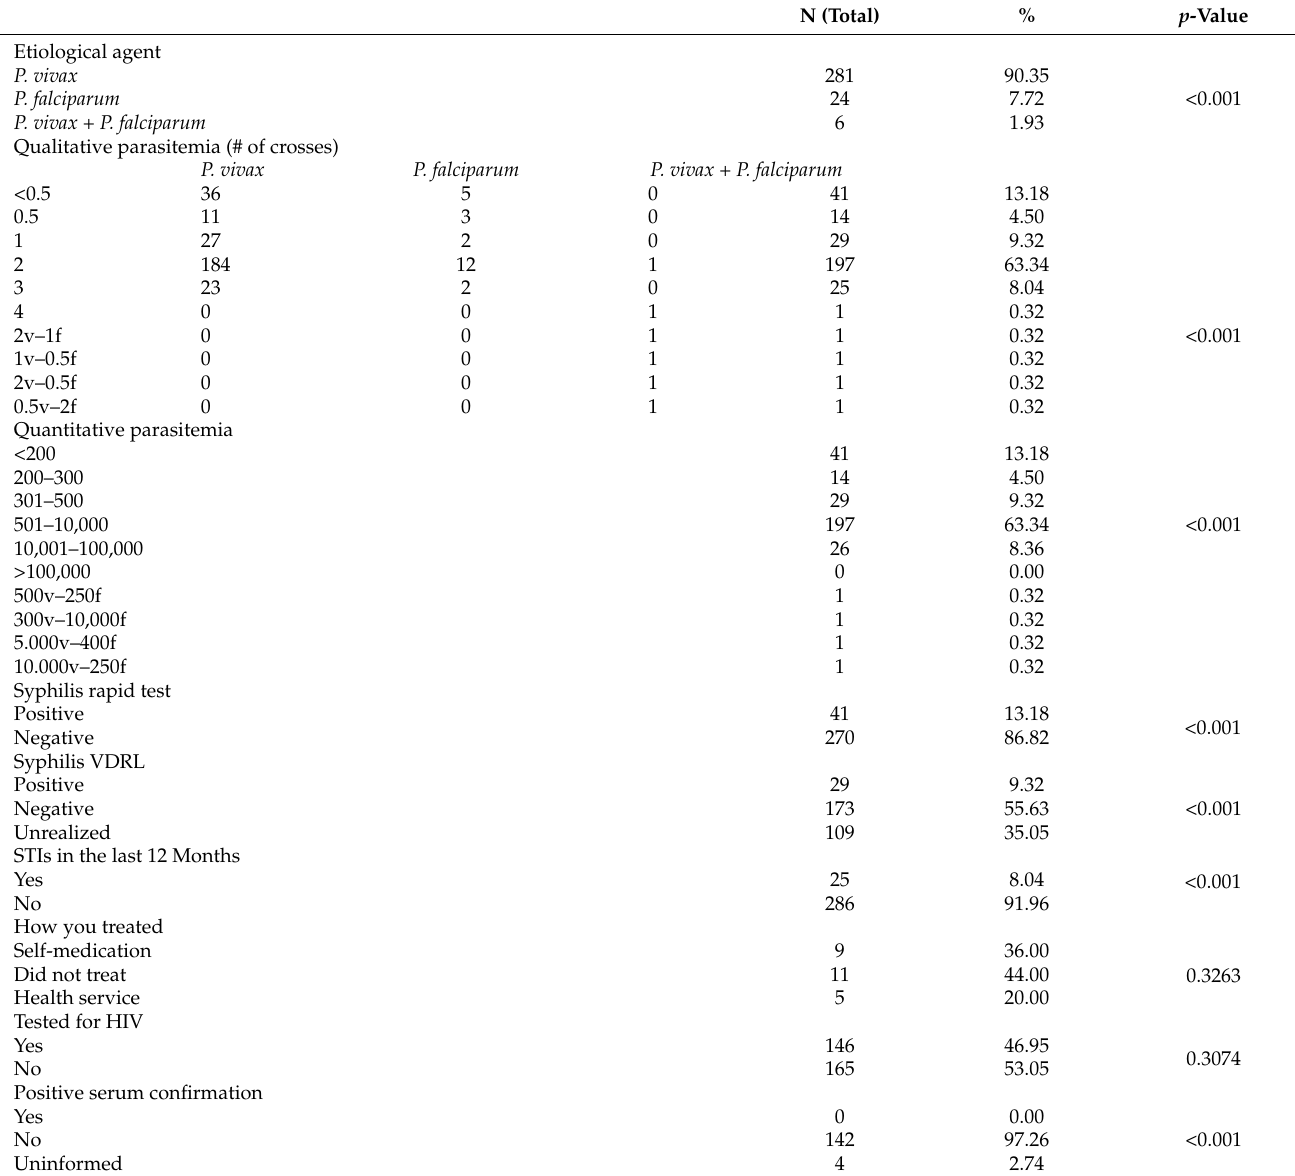
Table 3. Epidemiological characteristics of malaria-positive individuals from a mining area in the Brazilian Amazon.